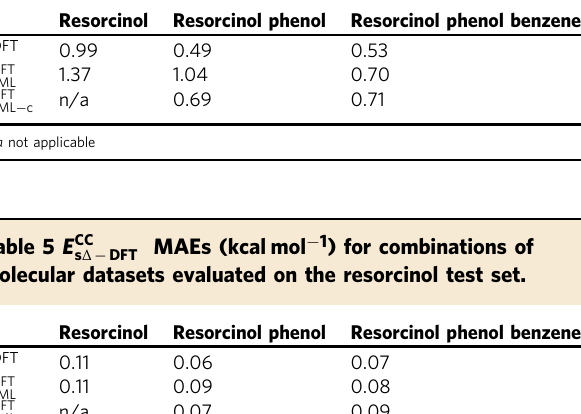
Table 4 E CC MAEs (kcal mol − 1 ) for combinations of sML molecular datasets evaluated on the resorcinol test set.